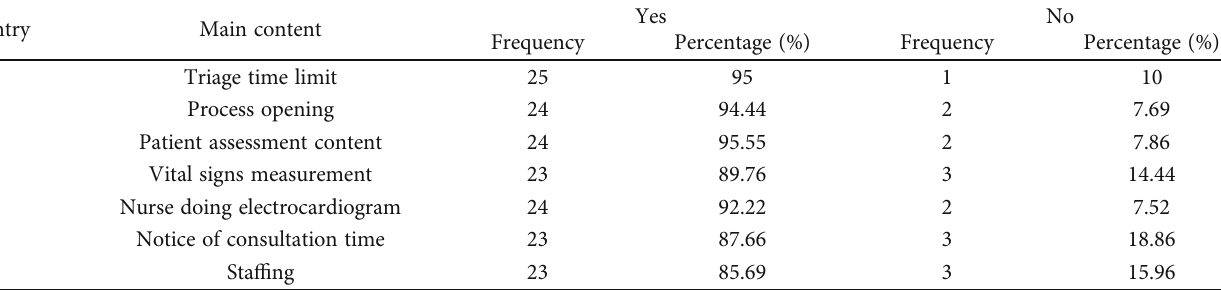
Table 5: Investigation results of Delphi experts ’ supplementary